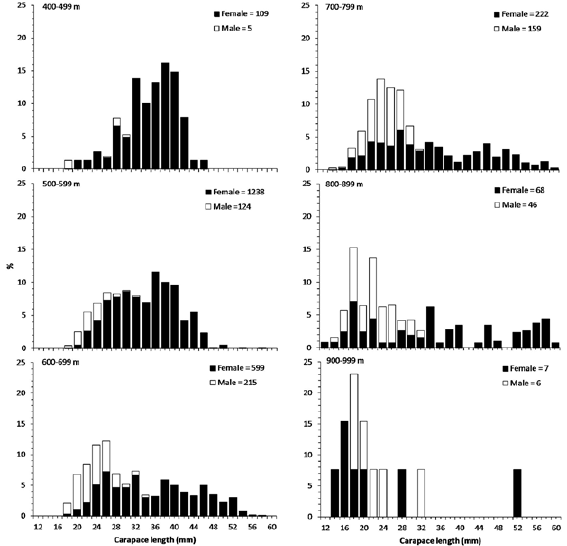
Fig. 3. – Length-frequency standardized distributions of A. anten- natus caught during the STRATUM survey by depth strata. Closed squares, females; open squares,